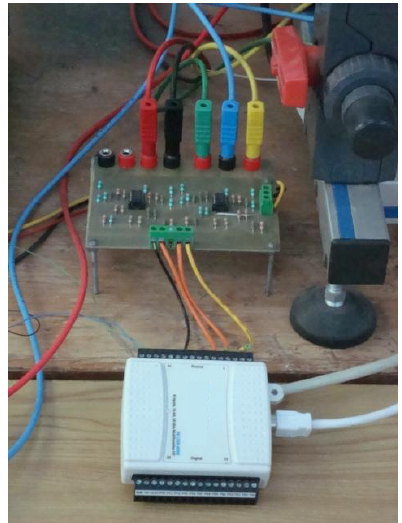
Figure 4. Connections and conditioning